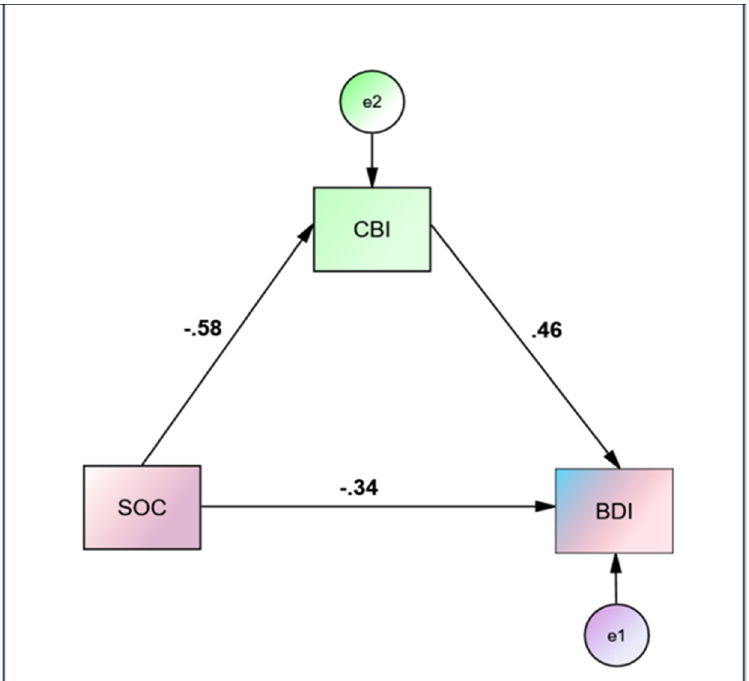
Figure 1. Mediation analysis of Copenhagen Burnout Inventory (CBI) on Sense of Coherence questionnaire (SOC)—Beck’s Depression Inventory (BDI) relationship.